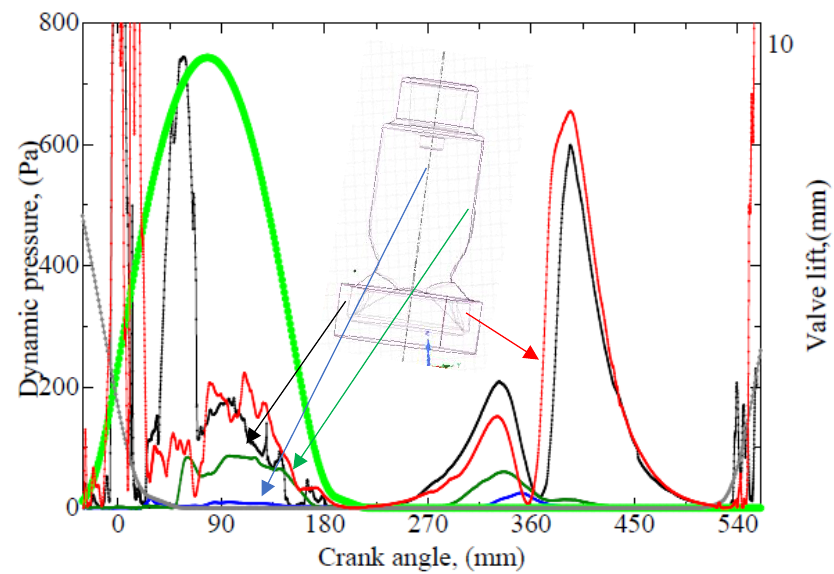
ff erent places of the Figure 9. The pressure at the different places of the prechamber. Figure 9. The pressure at the di